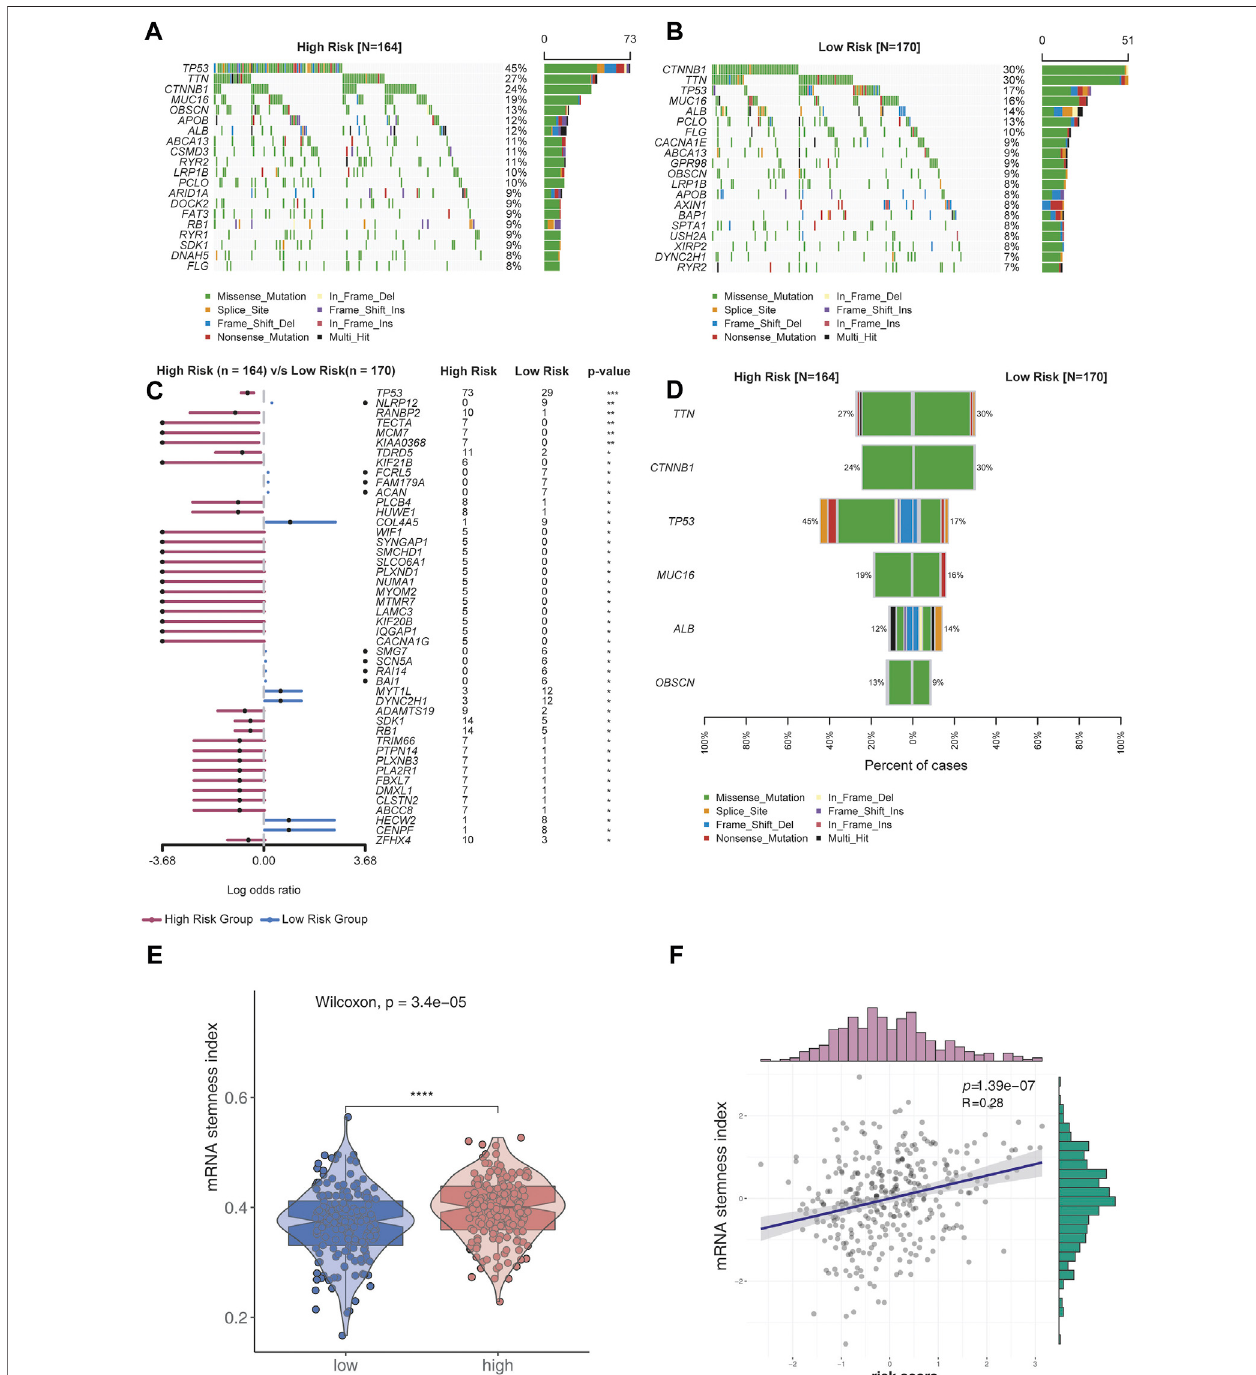
FIGURE4| Analysisofgenomic variationsinthehigh-riskgroup andlow-riskgroup. (A,B) Oncoplotdisplayingthesomaticlandscapeofthehigh-risk (A) andlow- risk (B) groups. Genes were arranged according to their mutation frequencies. The Y-axis represents the gene name, and the abscissa represents the sample name. Different colors represent different mutation types. (C) Forest plot showing differentially mutated genes between the high- and low-risk groups. The adjacent table includesthenumberofsamplesinthehigh-and low-risk groupswithmutationsinthehighlightedgene. p -valueindicates signi fi cance threshold: (***) p < 0.001,(**) p < 0.01,Fisher ’ sexacttest. (D) Cobarplotsshowthemostrecurrentlymutatedgenesinthehigh-andlow-riskgroups. (E) mRNAstemnessindexofthelow-riskgroup was lower than that of the high-risk group. (F) mRNA stemness index was positively correlated with risk scores.